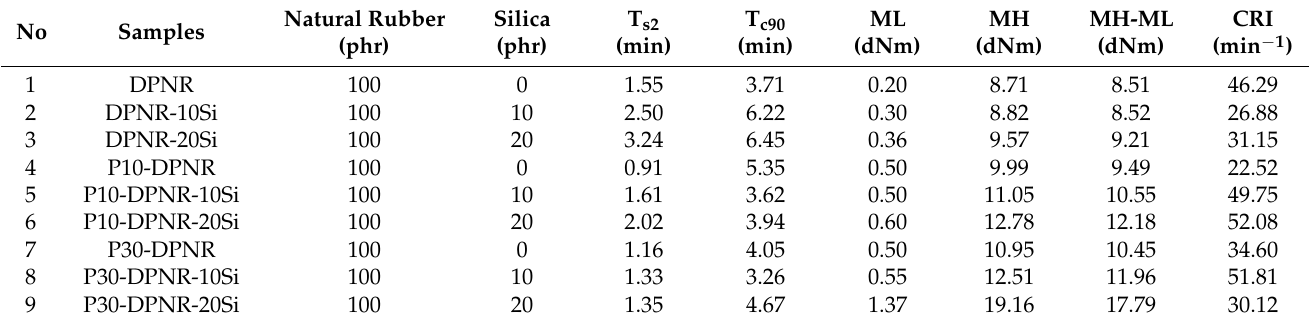
Table 4. Cure parameters obtained from MDR at a vulcanizing temperature of 150 ◦